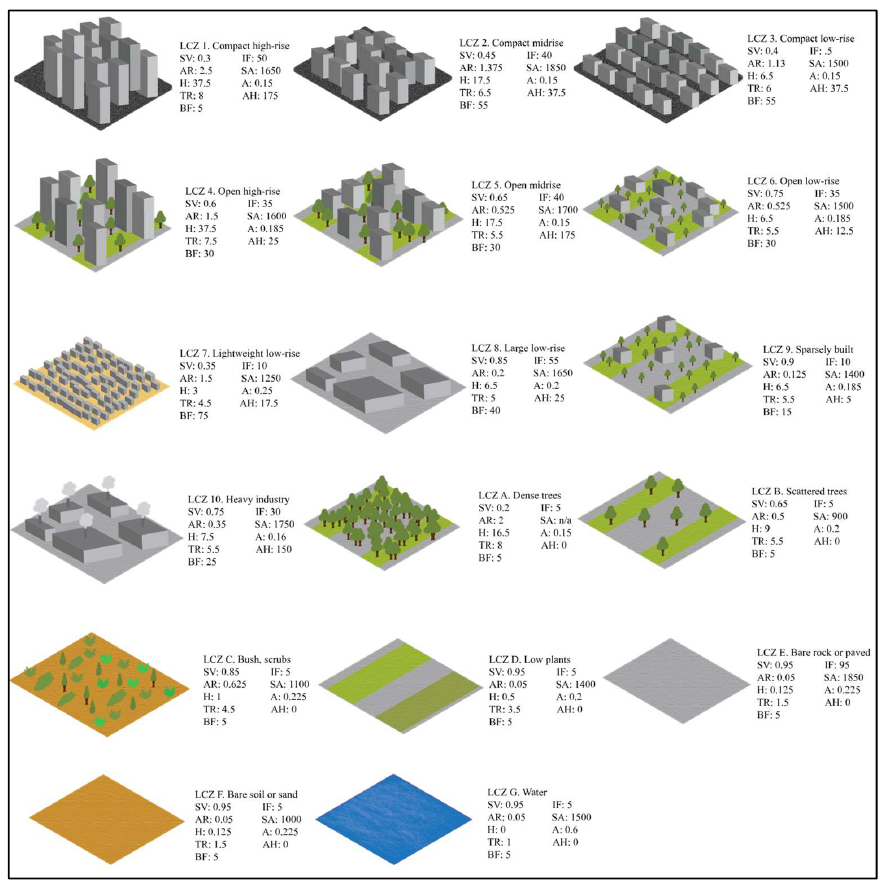
Figure 1. Graphical representation of each local climate zone (LCZ) type; and average values of their surface structure/land cover/anthropogenic heat flux parameters, as derived from the value ranges given in Stewart and Oke [1]. Table 1. D ij value for each pairwise combination of local climate zone (LCZ) types. Higher D ij values indicate that a higher penalty (i.e., multiplier) is applied to misclassifications between the corresponding LCZ types.